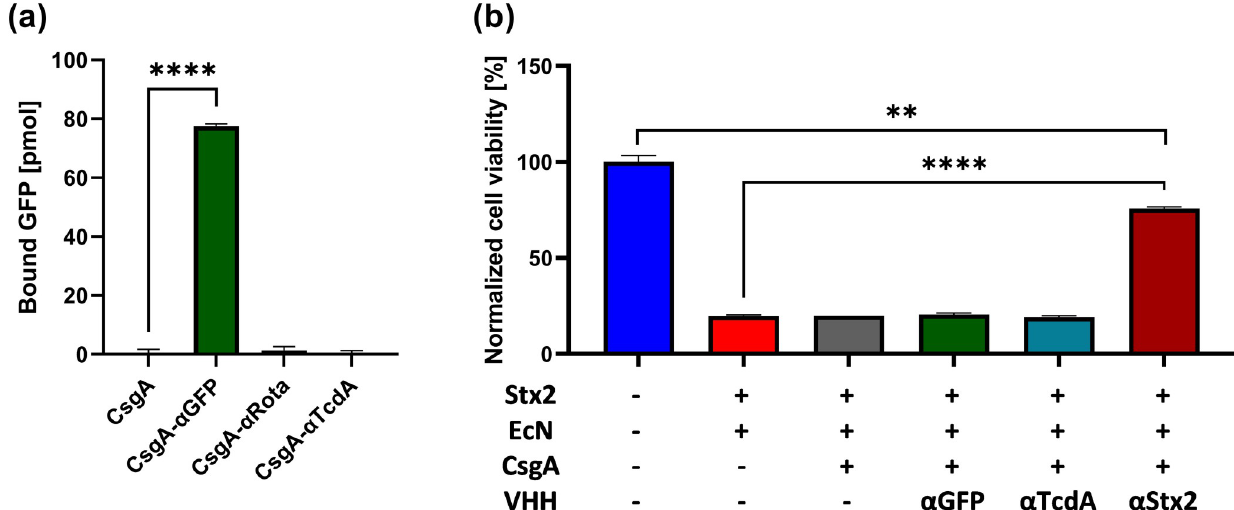
Fig 5. CsgA-VHHs can bind soluble proteins. (a) GFP pull-down assay. After incubation with 150 nM GFP, PBP8 CsgA- α GFP bound specifically to its target, as demonstrated by the depletion GFP in the cell supernatant. (b) Stx2 pull-down assay. PBP8 CsgA- α Stx2 was used to selectively remove Stx2 upon incubation in a 10 ng/mL Stx2 solution. Supernatants were added to Vero cell monolayers and cell viability was measured. Data presented as mean ± SEM. One-way ANOVA (P < 0.0001) was performed to test presence of difference between conditions, P-values calculated by Welch’s t-test. �� P < 0.01; ���� P <